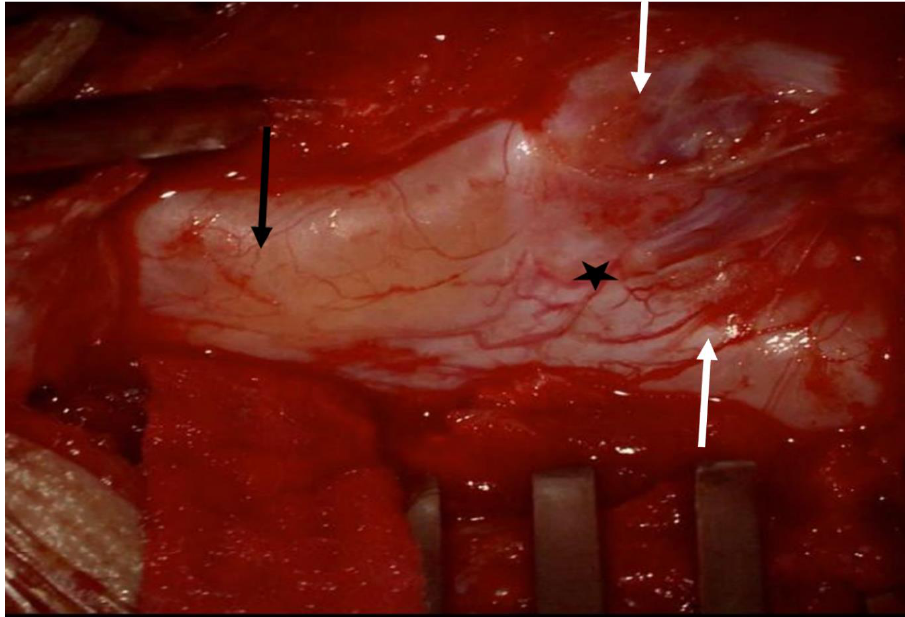
Figure 3. An intra-operative photo illustrates the split spinal cord within two dural sacs (SCM type II) prior to dural opening. The black arrow points to the spinal cord proximal to the bifurcation point. The stars points to the bifurcation points. The two white arrows point to the two cords distal to the bifurcation point.